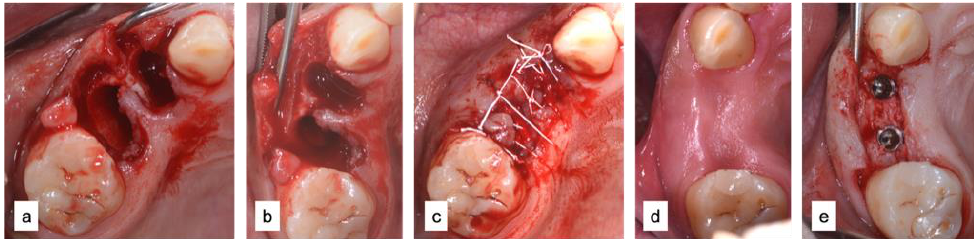
Figure 7. Cases 4 – 5: ( a ) vestibular bone of zone 24 – 25 was exposed, and an envelope was created; ( b ) cortical lamina glued on the vestibular bone; ( c ) sockets were filled with collagen sponge, single sutures on papilla and cross sutures to lock the sponge; ( d ) soft tissue healing at 4 months; ( e ) bone healing and implants ’ placement at 4 months.